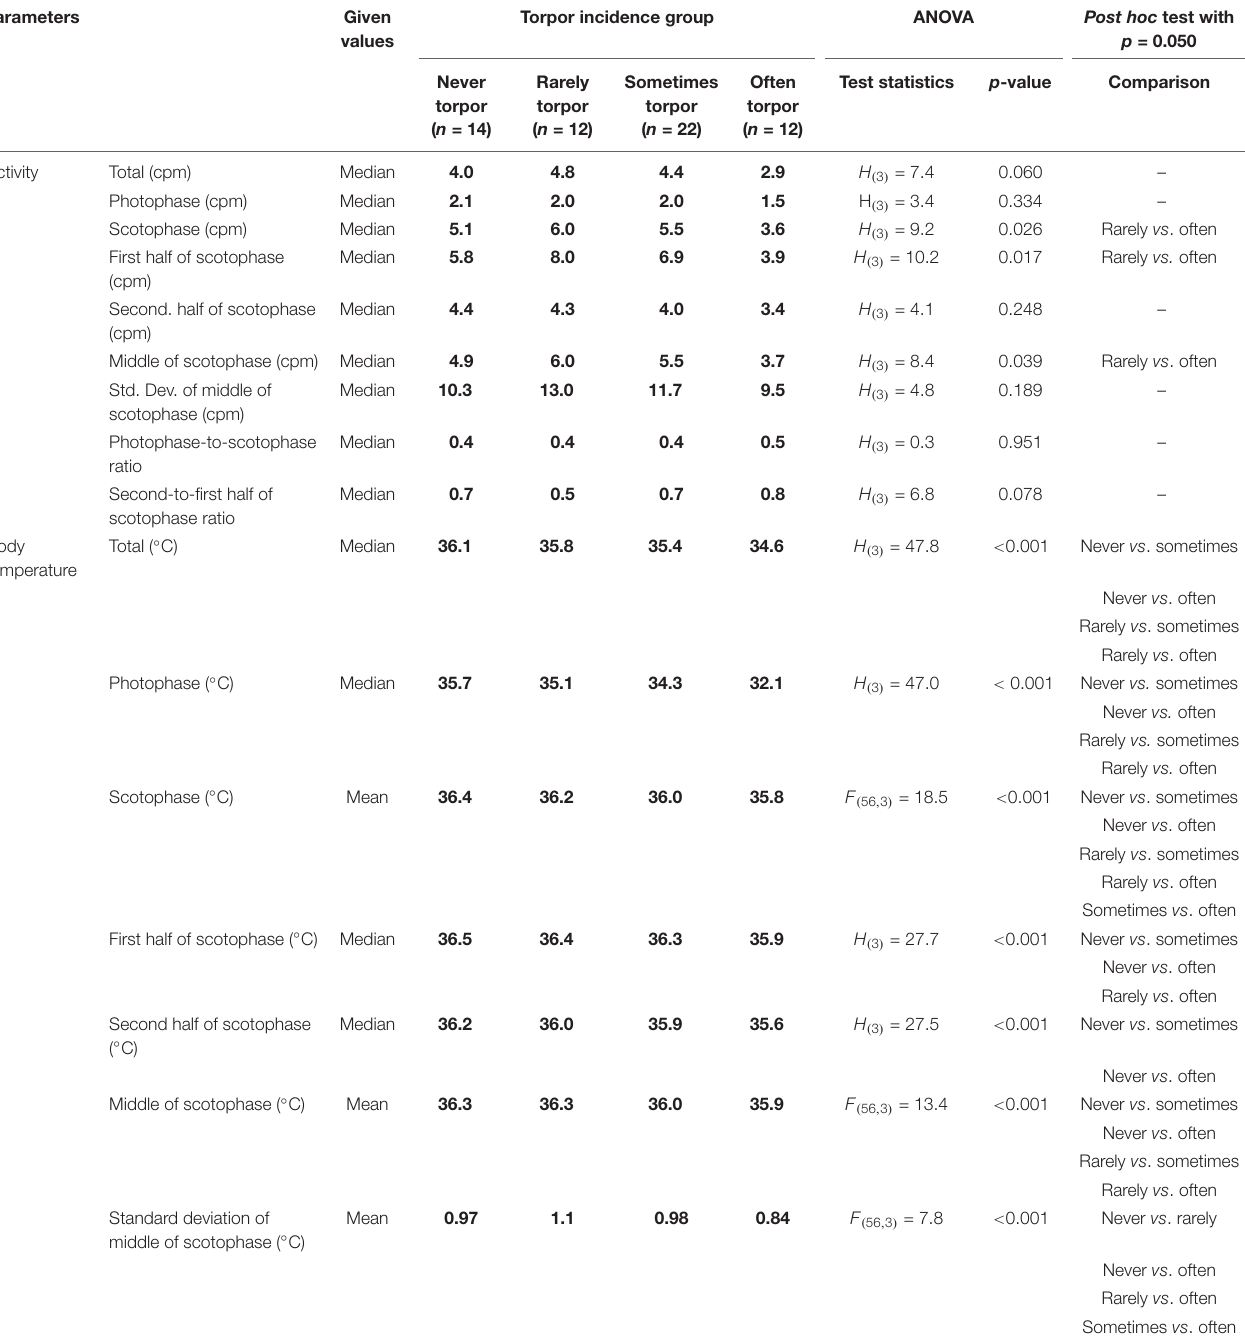
TABLE 3 | Phenotyping of the torpor incidence groups of approach 1 according to the activity and body temperature per time frame. Parameters Given Torpor incidence group values